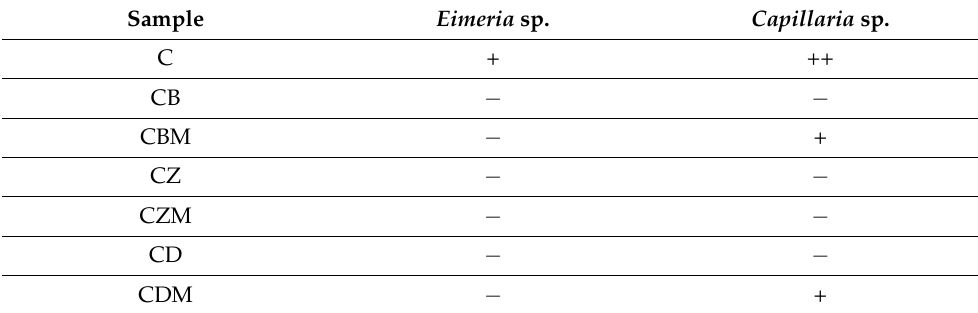
Table 5. Developmental forms of parasites found in the tested